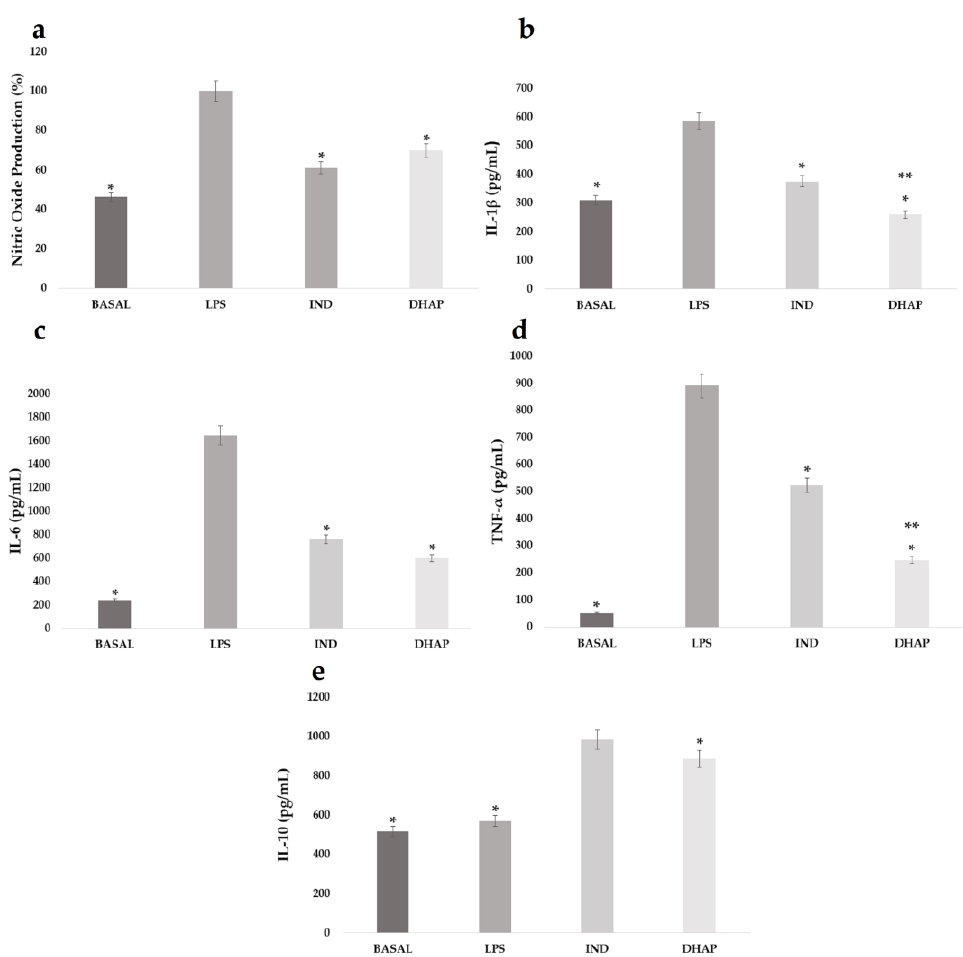
Figure 2. Effect of DHAP and IND at concentrations of 91.78 µ M (25 µ g/mL) and 4.79 µ M (17.1 µ g/mL), respectively in J774A.1 macrophages stimulated with LPS on the production of NO ( a ), IL-1 β ( b ), IL-6 ( c ), TNF- α ( d ) and IL-10 ( e ). The graph represents the mean ± standard error of three